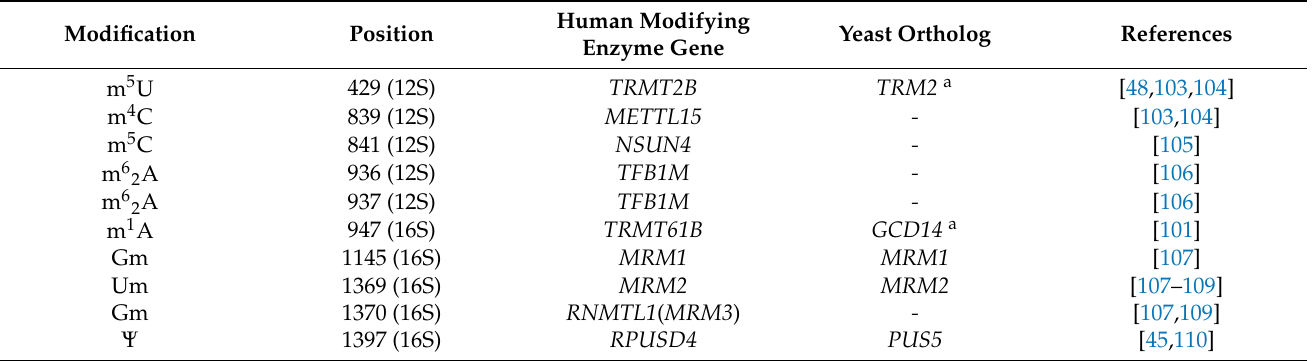
Table 3. Nucleotide modifications found in human mt-rRNAs, the position of the modification (referred to the mtDNA encoding nucleotide), human gene(s) encoding for the modifying enzyme(s) and their yeast orthologs, if